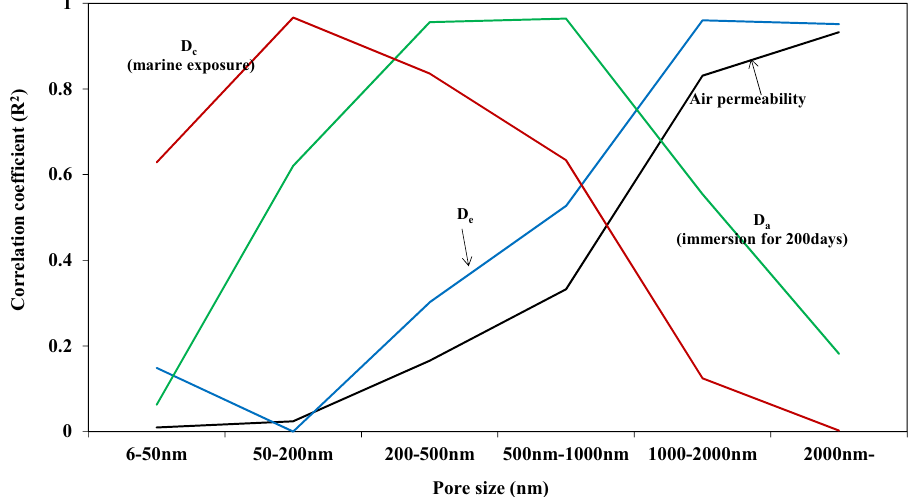
Fig. 12 Correlation coefficient of durability indicators for exposed concrete at different pore